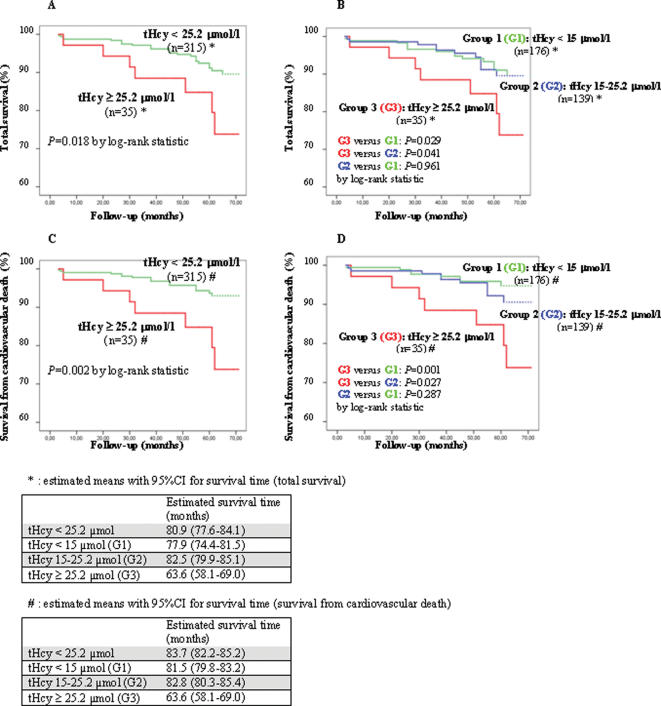
Kaplan-Meier survival plots for total mortality (A–B) and cardiovascular death (C–D) in relation to tHcy levels.Cutoff points for tHcy strata at 25.2 µmol/l in plots A and C, at 15 and 25.2 µmol/l in plots B and D.